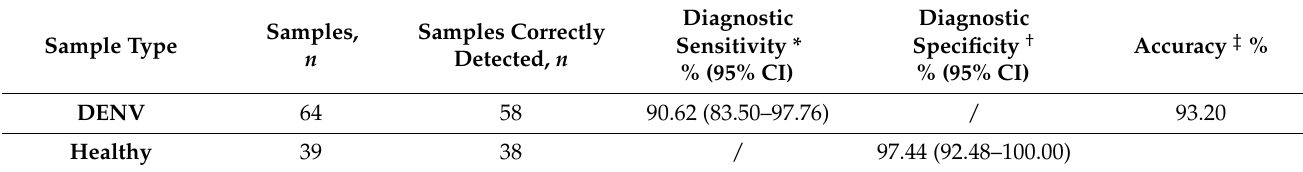
Table 2. Immunological MFEA readout in biological